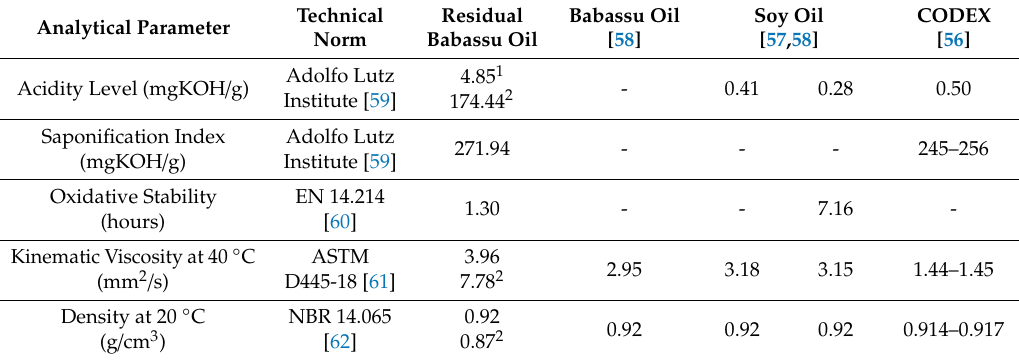
Table 3. Results of the physicochemical characterization of residual babassu